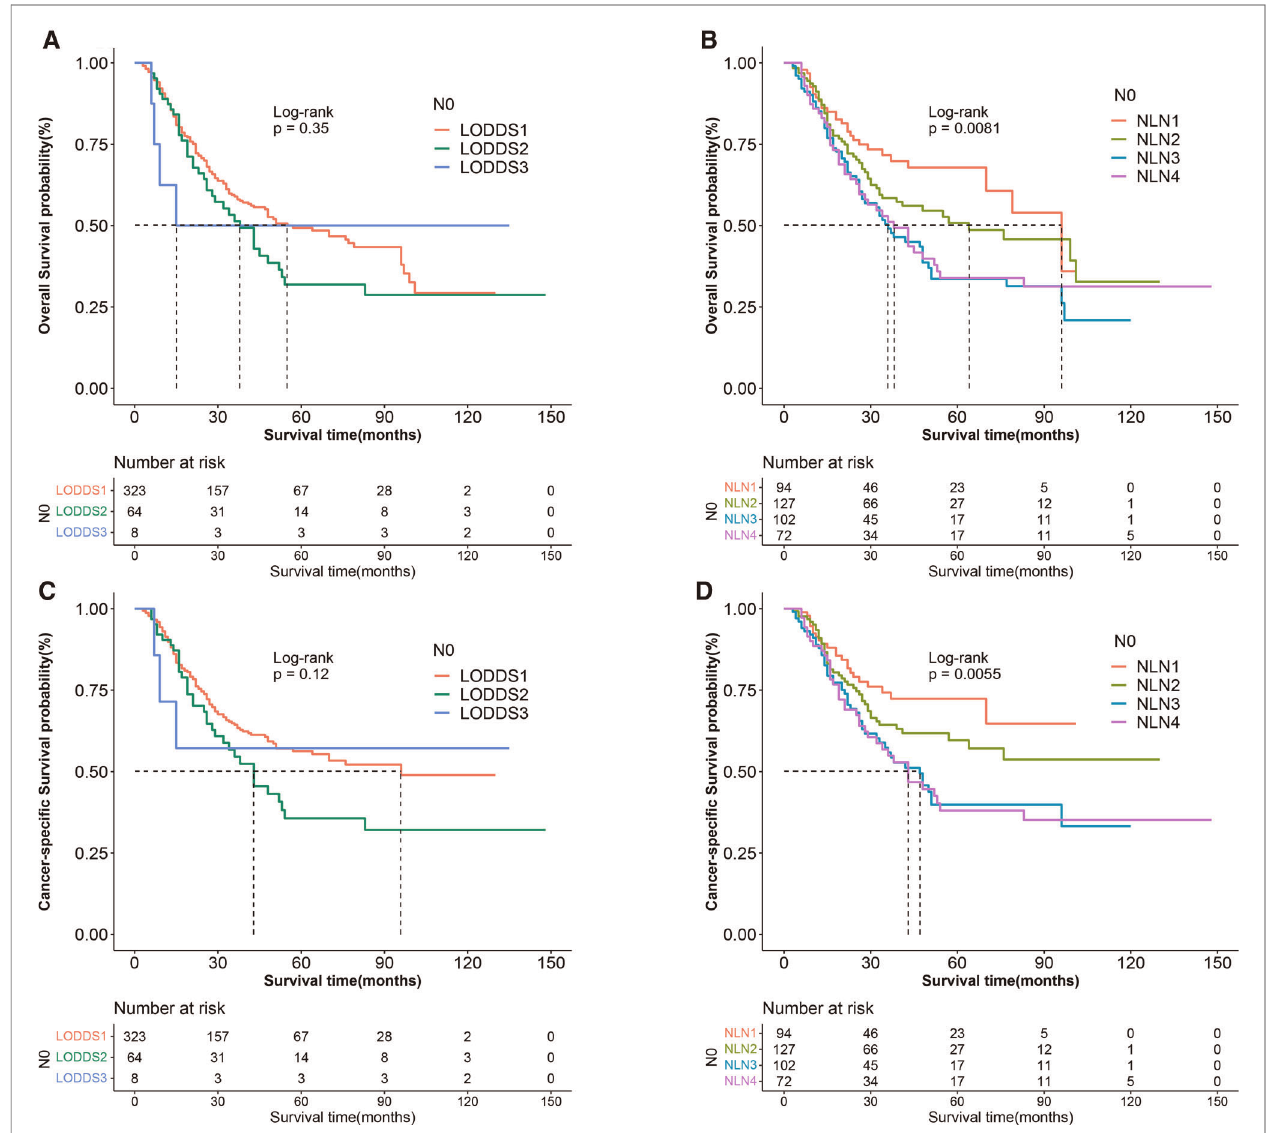
FIGURE 7 | Kaplan – Meier survival curves of OS according to ( A ) LOODS, ( B ) NLN staging system and CSS according to ( C ) LODDS, and ( D ) NLN staging system for gastric adenocarcinoma patients after NAT with ypN0. (OS, overall survival; CSS, cancer speci fi c survival; LODDS, log odds of positive lymph node; NLN, negative lymph node; NAT, neoadjuvant